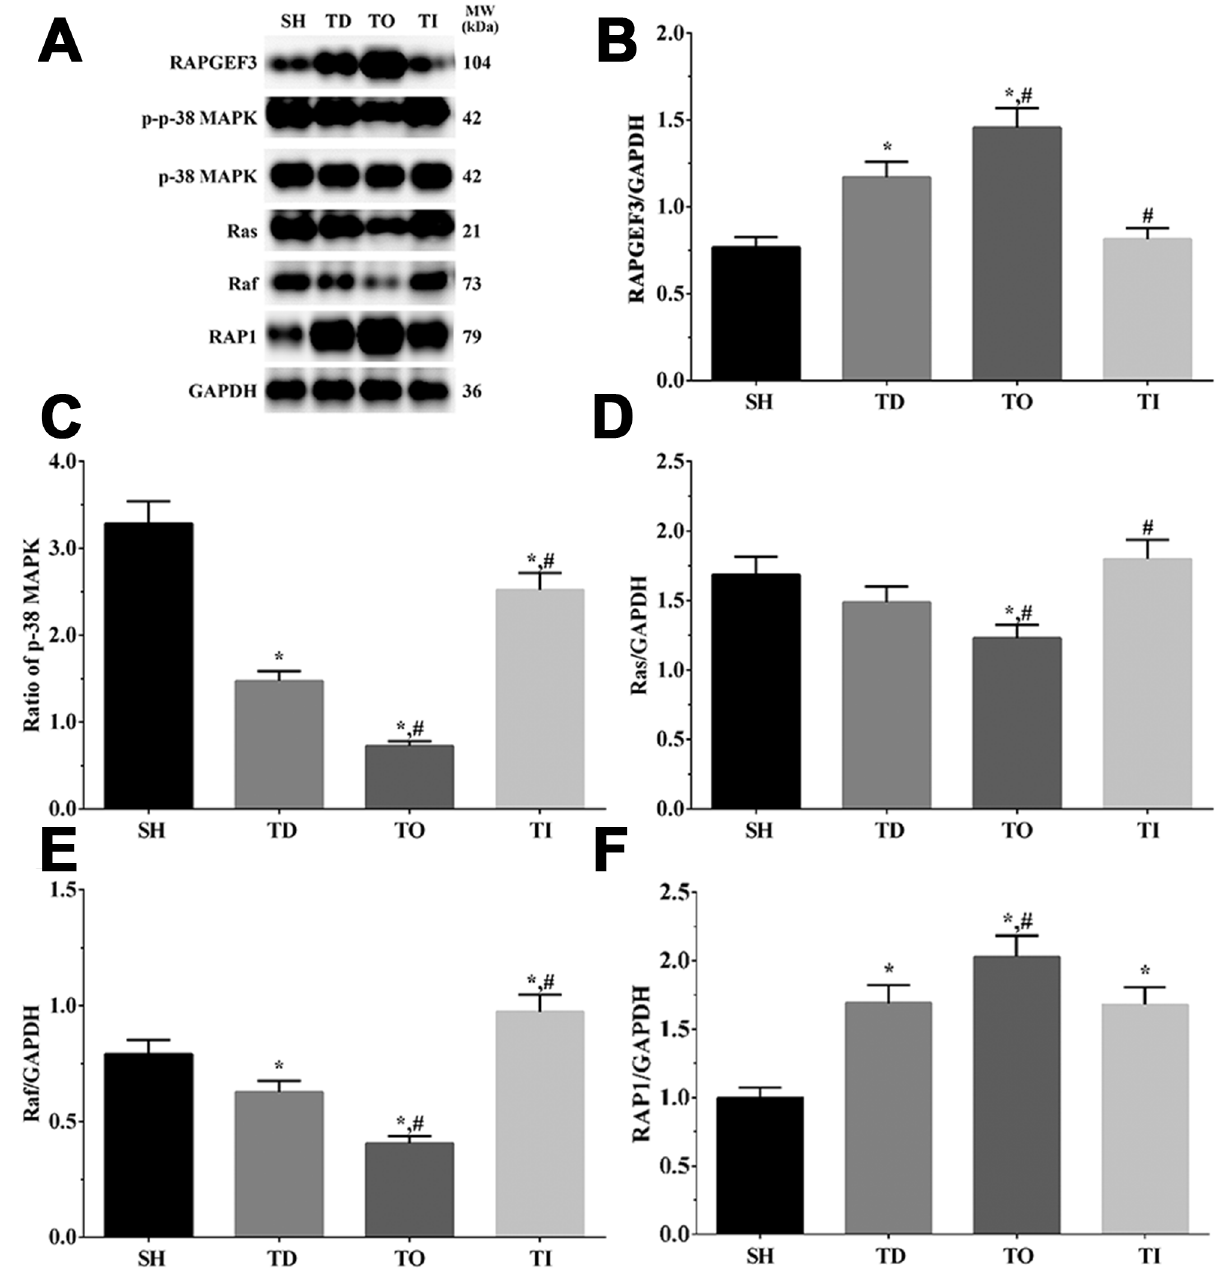
Figure 8 – Activation of Ras/Raf/MAPK in brain tissue of rats. (A) Western blotting analysis of RAPGEF3, p-38 MAPK, Ras, Raf and PKC in glial cells. (B-F) Quantitative analysis of each target protein. Data was presented as mean ± SD, each experiment was repeated for three times. *P<0.05 vs SH group of rats. #P<0.05 vs signal dezocine treatment group. NC: normal group, DT: dezocine treatment group, DO: dezocine treatment combined with RAPGEF3 overexpression group, DI: dezocine treatment combined with RAPGEF3 inhibition group. SH: sham group, TD: dezocine treatment group, TO: dezocine treatment combined with RAPGEF3 overexpression group, TI: dezocine treatment combined with RAPGEF3 inhibition